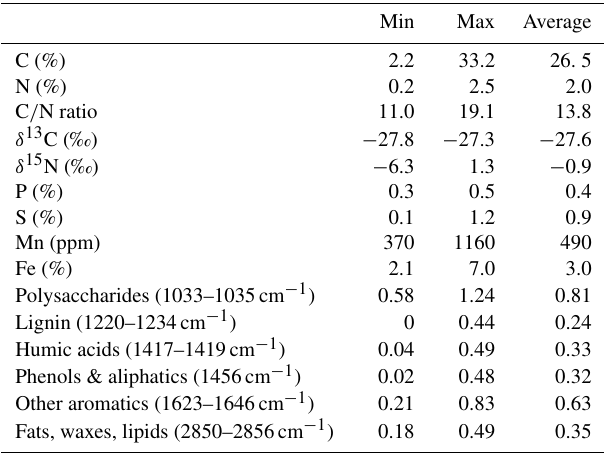
Table 2. C, N, P, S, Mn and Fe contents, C / N and FTIR peak ratios (peak maximum for polysaccharides) of identified OM compounds, and their minimum and maximum values. n =